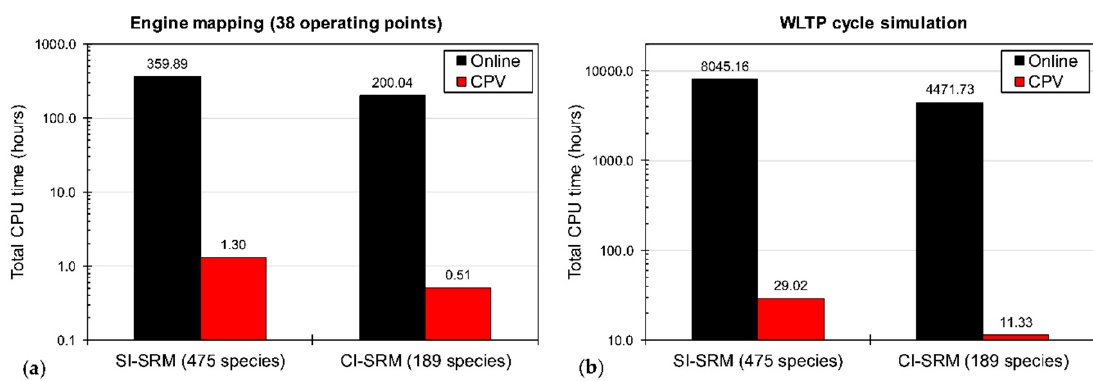
Figure 11. Comparison between online and tabulated chemistry solver computational performances for ( a ) a full engine performance mapping simulation campaign comprising a total of 38 operating conditions and ( b ) the simulation of the full WLTP cycle (30 min) in terms of combustion and emission simulations only.